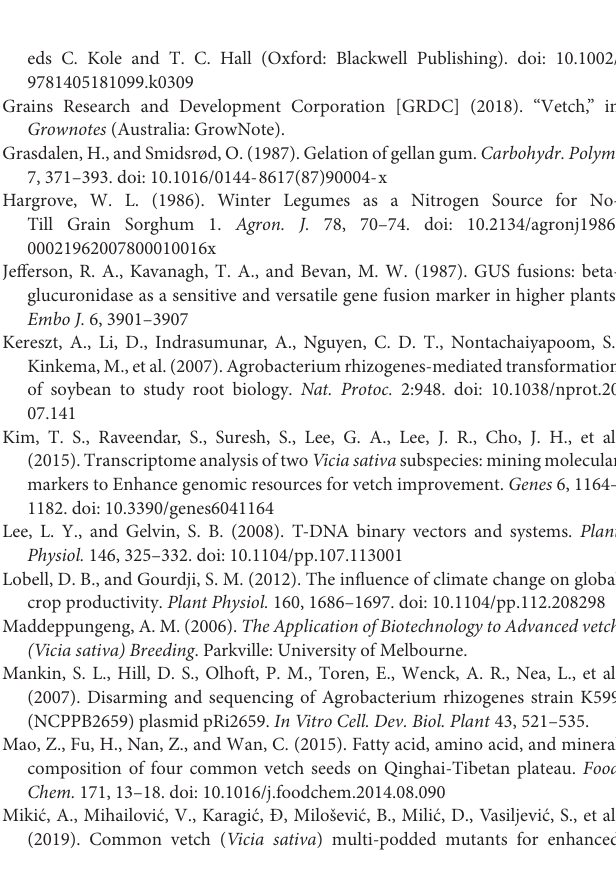
Supplementary Figure 1 | Hairy root induction on soil 24 days after infection with R. rhizogenes K599. (A) A highly branching hairy root (white arrow). (B) Hairy root emerged to the soil surface due to loss of plagiotropism (white arrow). Scale bar = 1 cm. Supplementary Figure 2 | GFP hairy root induction from (A) hypocotyl-epicotyl and (B) stabbed seedling. (A) Primary root was removed at day 0 of the infection with R. rhizogenes . (B) Primary root was kept during the hairy root induction period. GFP expressing transgenic hairy roots (green color) were detected using a hand-held blue light (Dark Reader Lamp – Clare Chemical Research), red color was the auto-florescence from tissue containing chlorophyll. White arrow indicates the wild type primary root. Scale bar = 1 cm. Supplementary Figure 3 | Lateral shoots of vetch seedling. (A) Vetch seedling 5 days after germination in vitro on RGM_NoSuc media. (B) A close-up of a lateral shoot. Black arrows indicate the lateral shoot position at the junction of cotyledon and epicotyledon. Scale bar (A) = 1 mm; (B) = 0.5